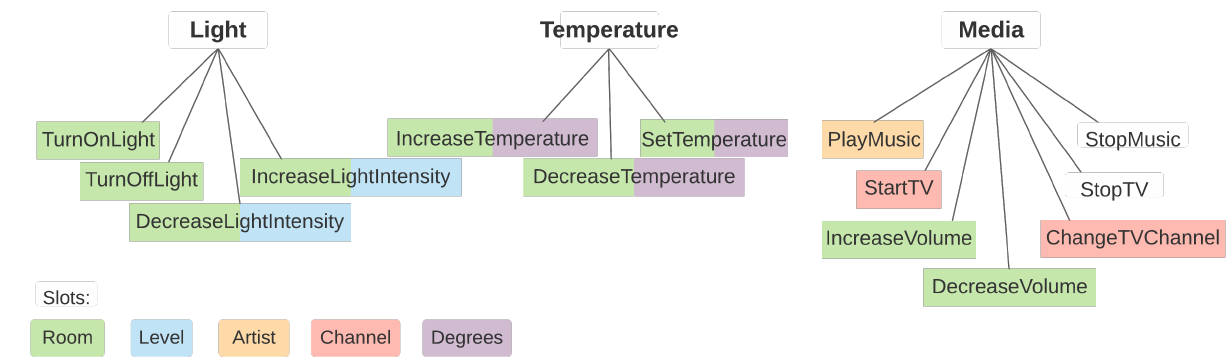
Figure 2. Intents taxonomy, color coded by